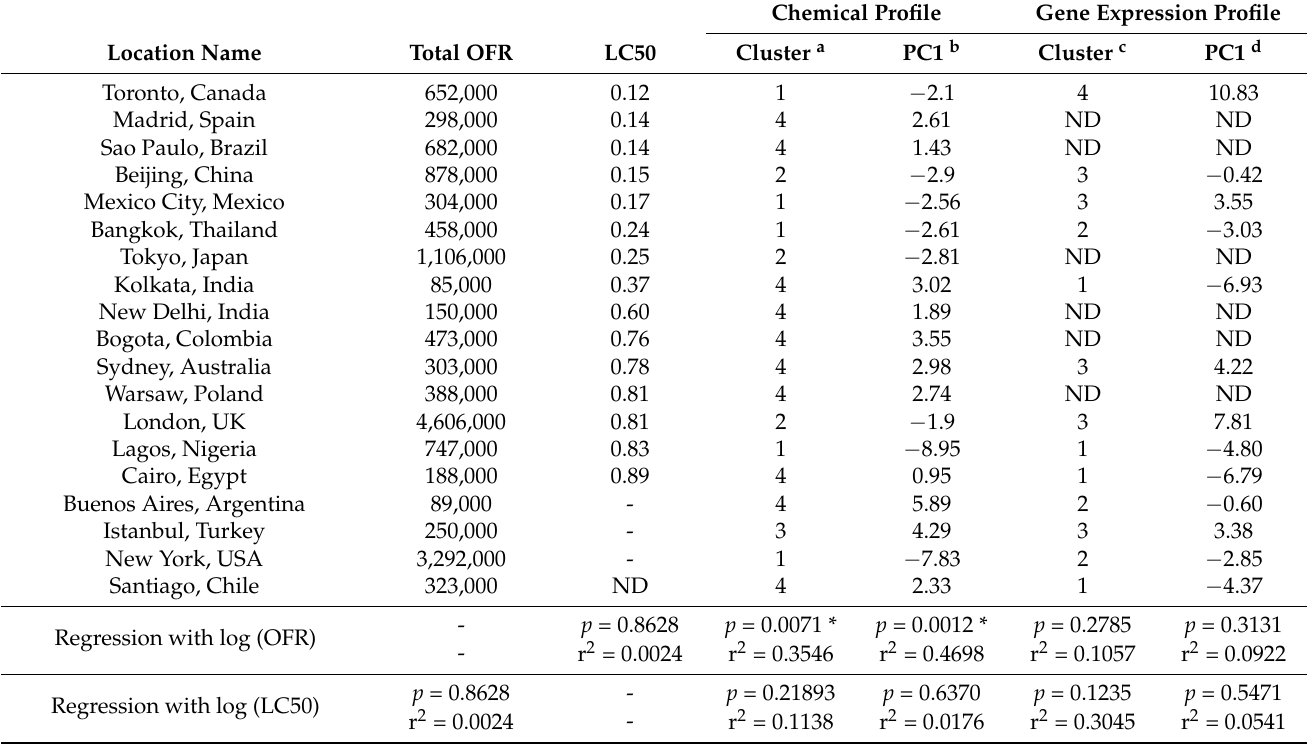
a = based on Figure 2A, b = based on Figure 2B, c = based on Figure 4A, d = based on Figure 4B; * p < 0.01, ND = not determined. “-” = no effect on